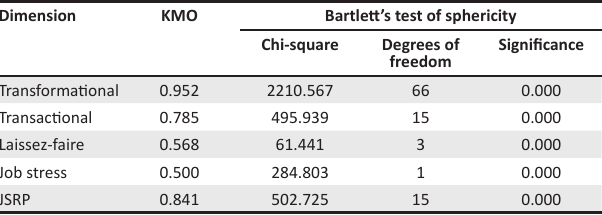
TABLE 1: Results of principle component analysis, Kaiser-Meyer-Olkin index, Bartlett’s test of sphericity, Cronbach’s alpha and average score for factors.